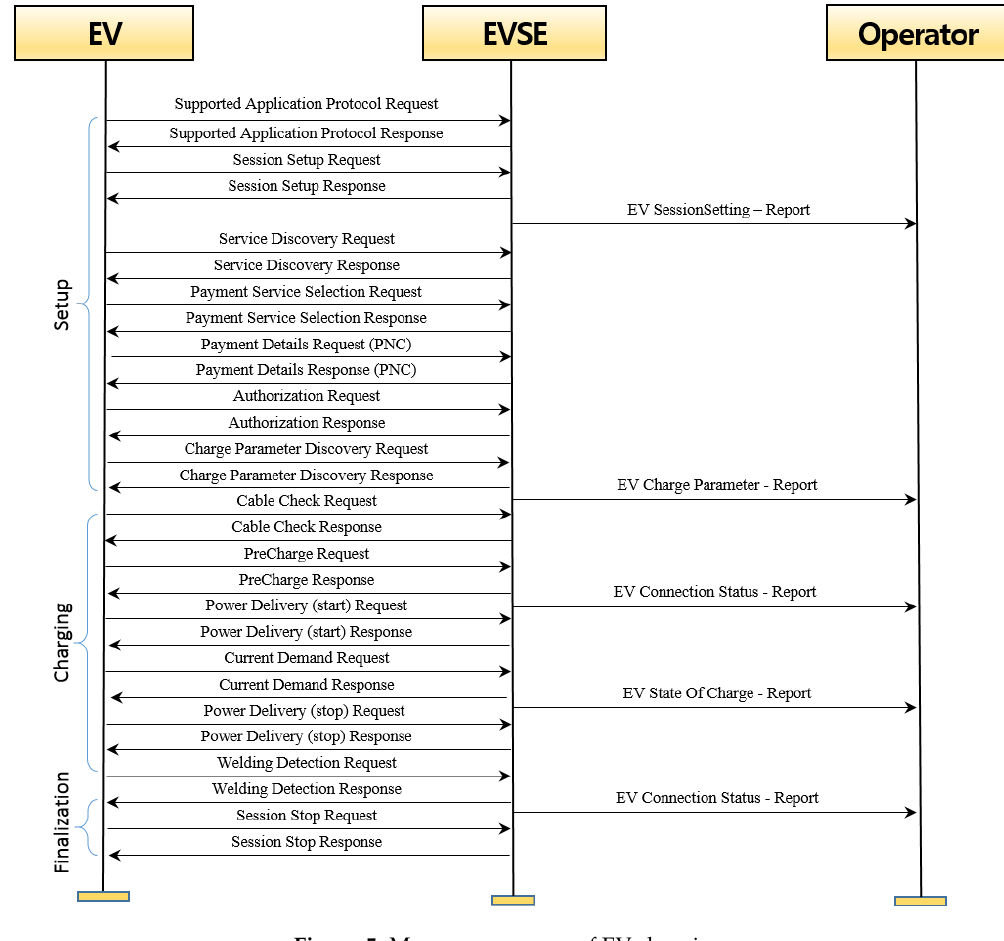
Figure 5. Message sequence of EV